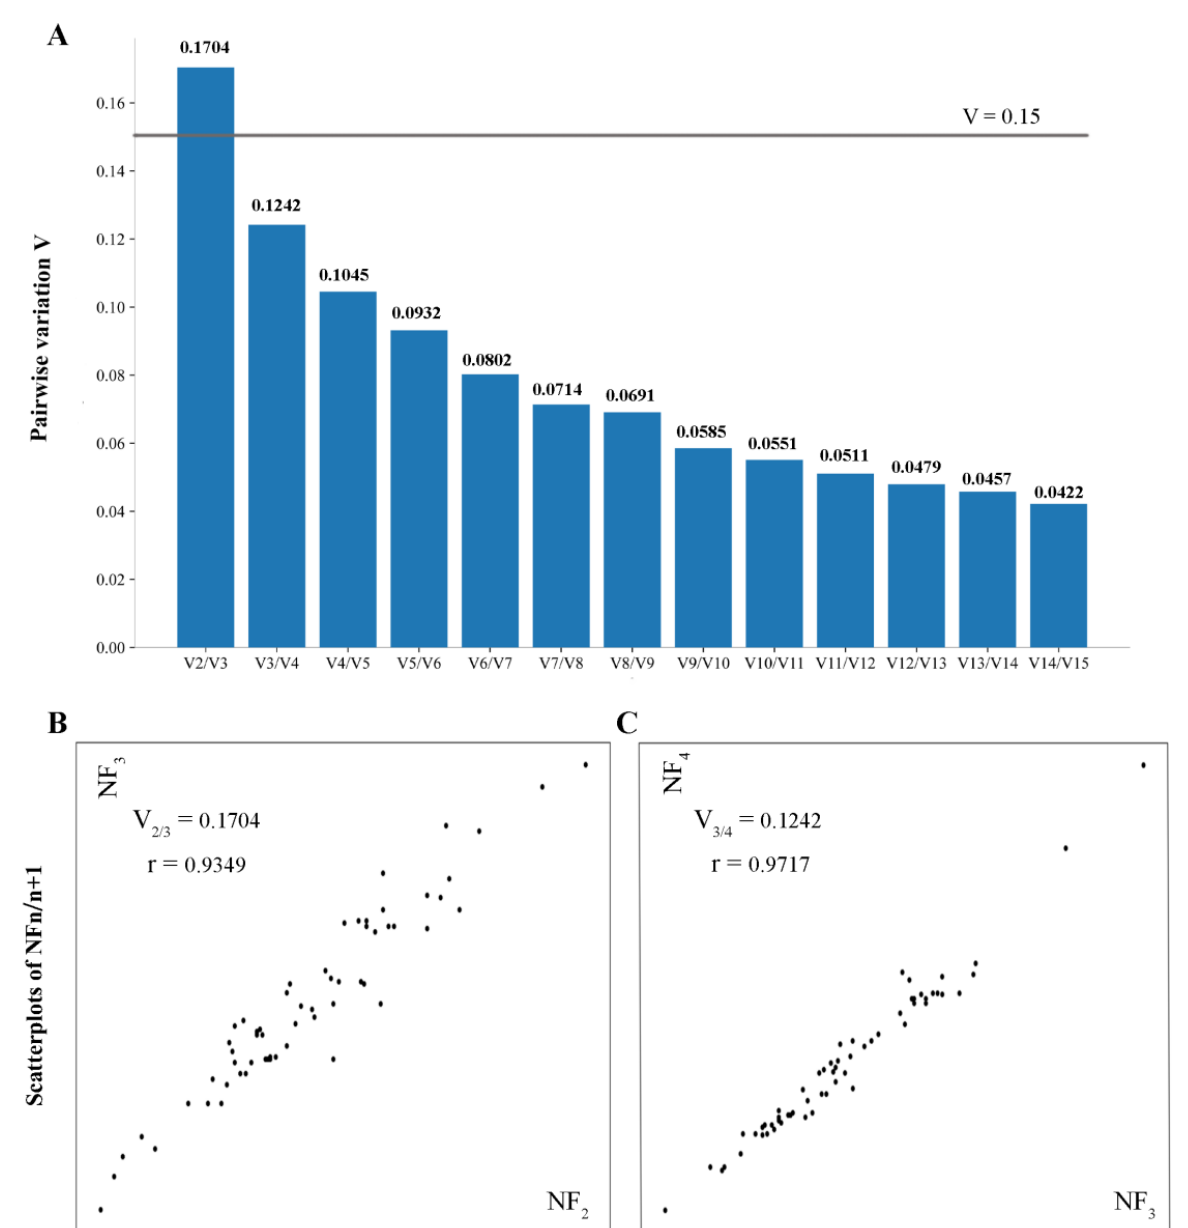
Figure 2. The best number of reference genes for RT-qPCR. ( A ) Pairwise variation (Vn/n + 1) analyses of 15 CRGs. The y -axis indicates Vn/Vn + 1 between the calculation of the NFn using the most stable reference genes and the NFn + 1 using an addition of the next most stable reference genes. The gray line depicts the cut-off value (V = 0.15). ( B , C ) NF n/n+1 scatterplots before and after the addition of (n + 1) reference gene ( x -axis and y -axis). The NF n was calculated using the geometric mean of the RQ data of n CRGs. r: Spearman rank correlation